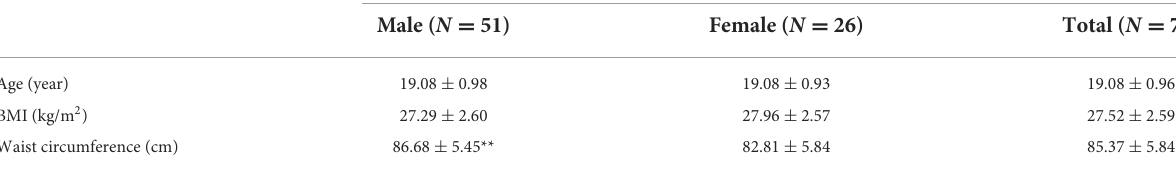
TABLE 1 Statistical data of baseline